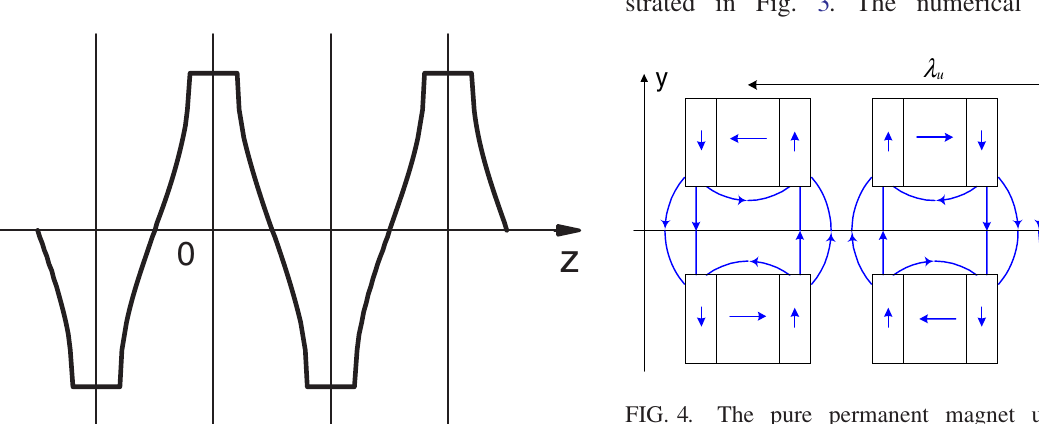
FIG. 2. Potential at the upper boundary.